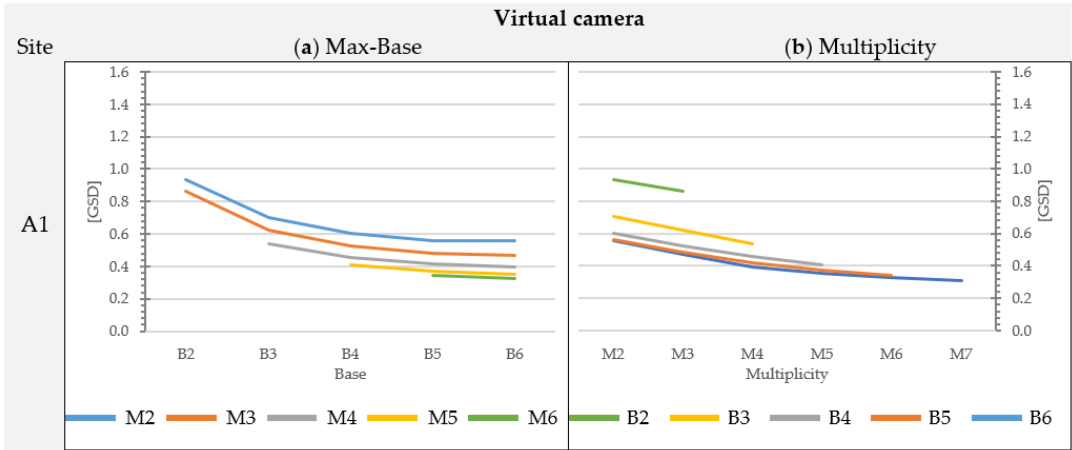
Figure 5. Graphs showing the standard deviation of the elevation disparity between DEMs and the reference model for Site A1 as a function of ( a ) max ‐ base variability and ( b ) multiplicity. (Value of standard deviation for combinations B1 ‐ M2 = 1.89 times the GSD).